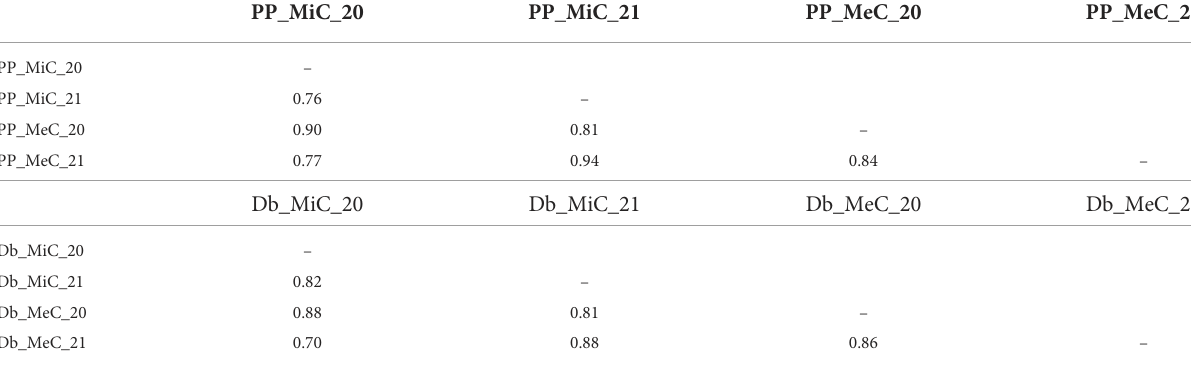
TABLE 3 Inter-trait Spearman correlations assessed in the mapping populations.